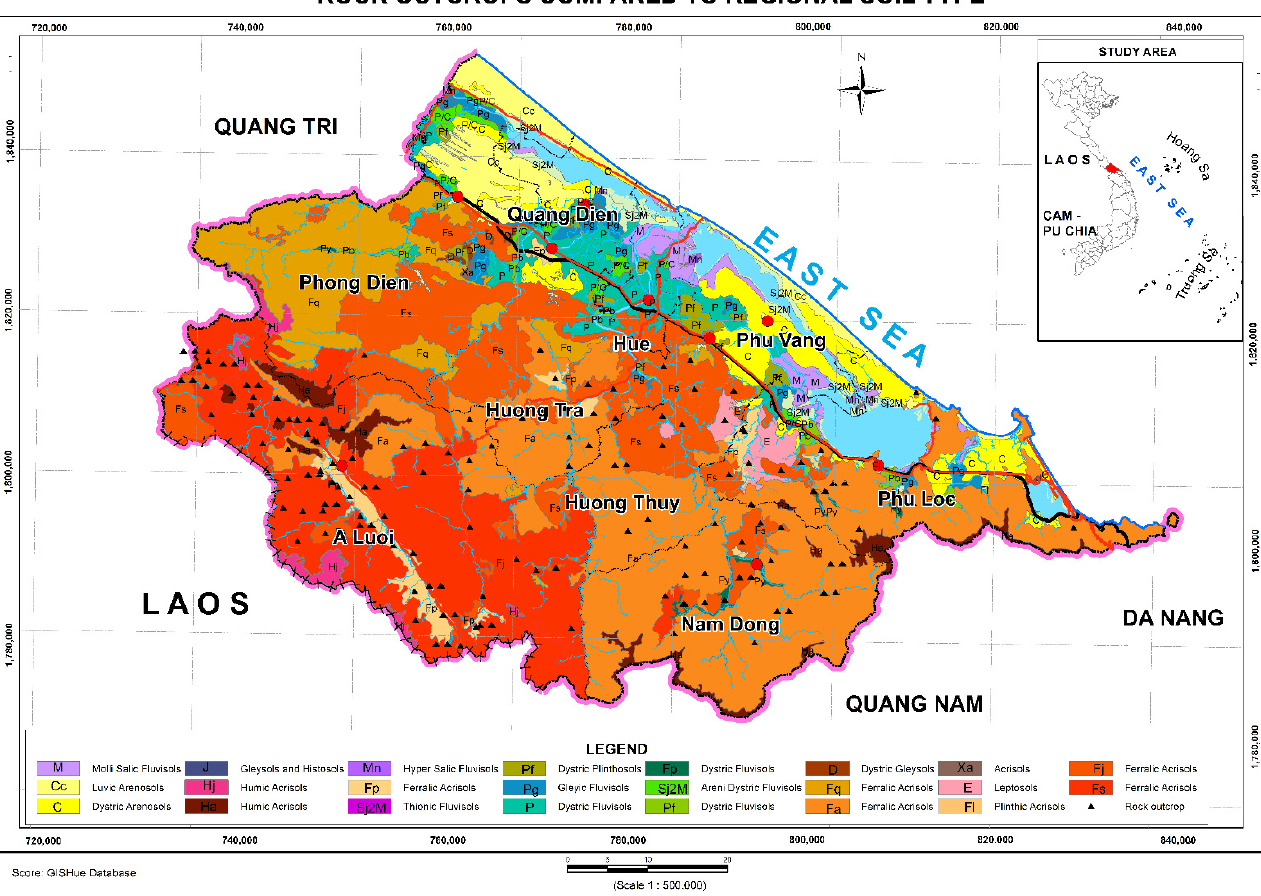
Figure 5. Rock outcrops compared to regional soil type on 25 April 2019. The spectral radiated energy values of image bands 10 and 11 (Table 5) were calculated using the Raster Calculator tool using two expressions: Radiance_b10.tif: 0.003342 × “LC81250492015024LGN00_10.TIF” − 0.1